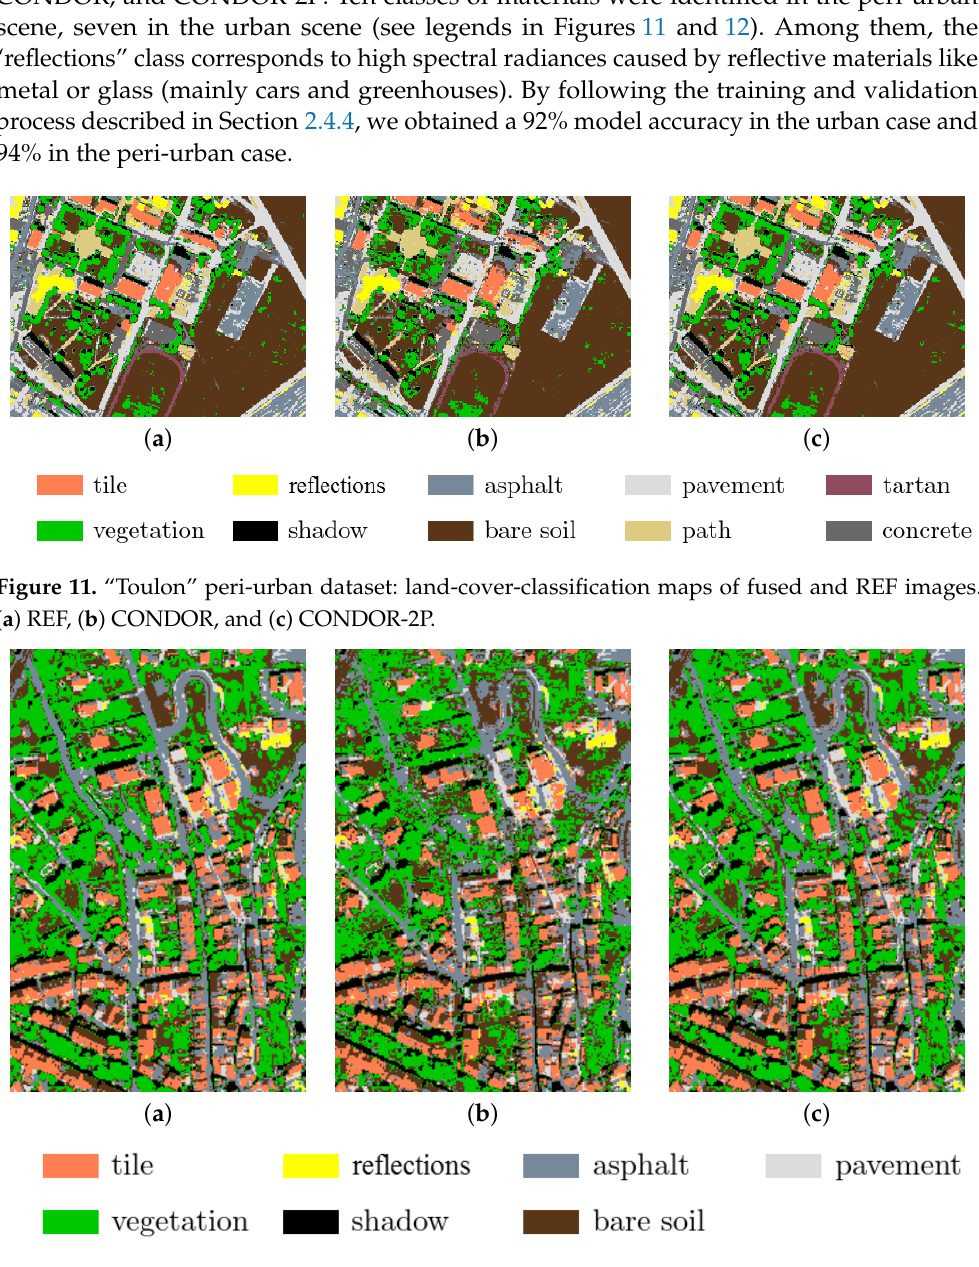
Figure 12. “Gardanne” urban dataset: land-cover-classification maps of REF and fused images. The “reflections” class corresponds to high spectral radiances caused by reflective materials like metal (e.g., cars) or glass (e.g., greenhouses). ( a ) REF, ( b ) CONDOR, and ( c )